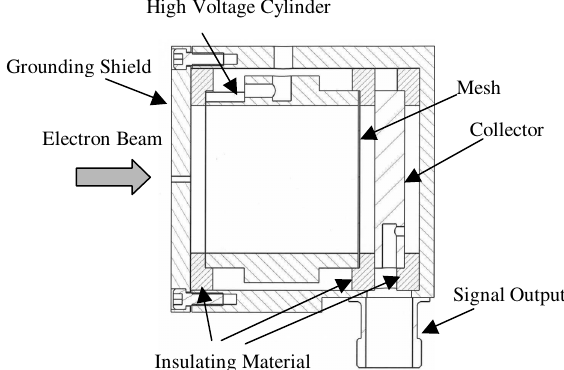
FIG. 1. Diagram of a cylindrical energy